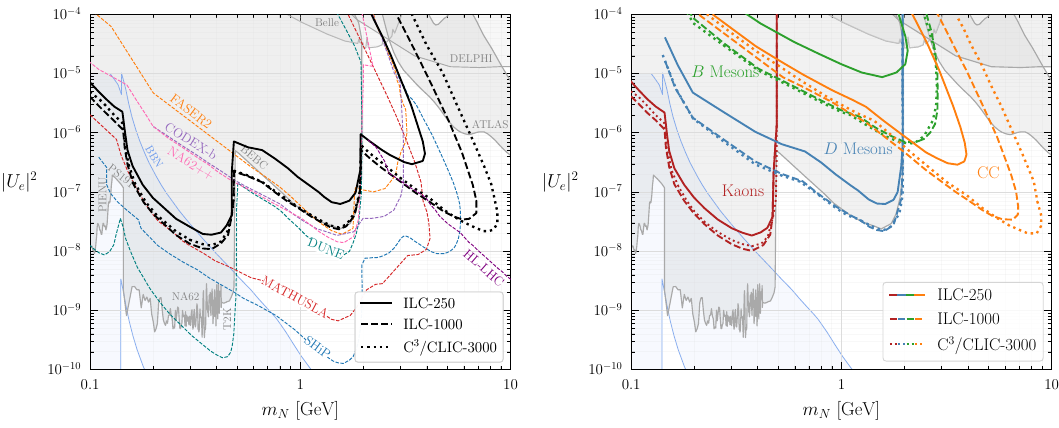
Figure 5 . Left: the reach of beam dump experiments for electron-mixed HNLs in the | U e | 2 vs m N plane for ILC-250 (black, solid curve), ILC-1000 (black, dashed curve), and C 3 /CLIC-3000 (black, dotted curve) assuming one year of operation. The limits are set by requiring 10 signal events in the detector. Existing experimental limits are depicted by the gray shaded region, while constraints from BBN are depicted by the blue shaded region. Limits from proposed experiments are depicted by the different dashed, colored curves. Right: same as the left plot where we decompose the bounds into contributions from the decay of kaons (red curves), D mesons (blue curves), B mesons (green curves), and charged-current scattering (orange